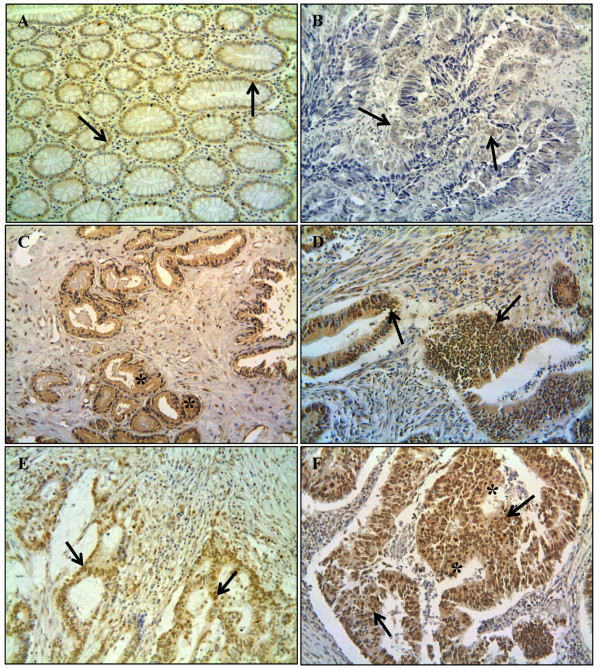
AEG-1 protein expression determined by immunohistochemistry. A) Moderate staining in the nucleus of normal mucosa (arrow nuclear staining); B) weak staining in the nucleus of primary tumour (arrow nuclear staining); C) strong staining in the cytoplasm of primary tumour (star symbol cytoplasmic staining); D) strong staining in the nucleus of primary tumour (arrows nuclear staining); E) moderate staining in the nucleus of lymph node metastasis (arrow nuclear staining); and F) strong staining in the both nucleus and cytoplasm of liver metastasis (arrows nuclear staining, star symbol cytoplasmic staining). Original magnification 200x.